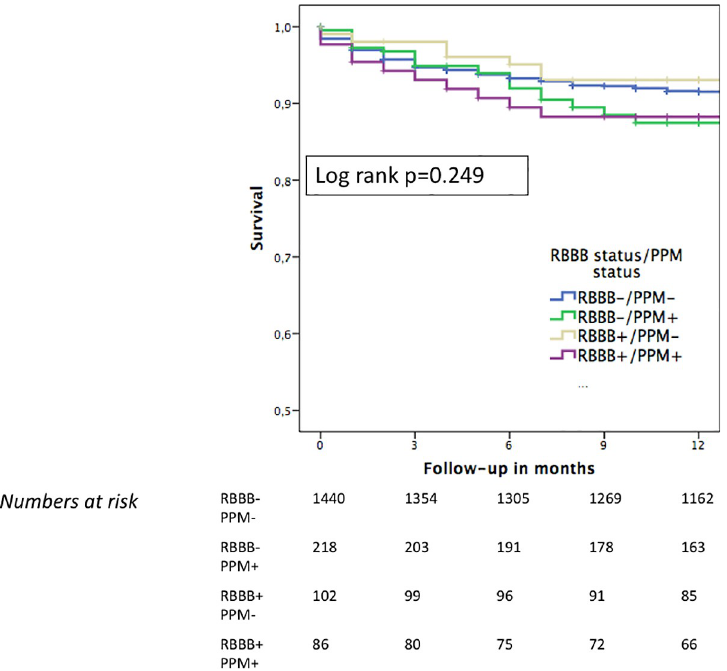
Fig 4. One-year cardiovascular survival in RBBB- and non- RBBB patients according to PPM implantation. During a follow-up time of 12 months, no difference in cardiovascular survival was observed between the subgroups of RBBB and non-RBBB patients with either a new PPM or no new PPM. Abbreviations: RBBB = right bundle branch block; PPM = permanent pacemaker.